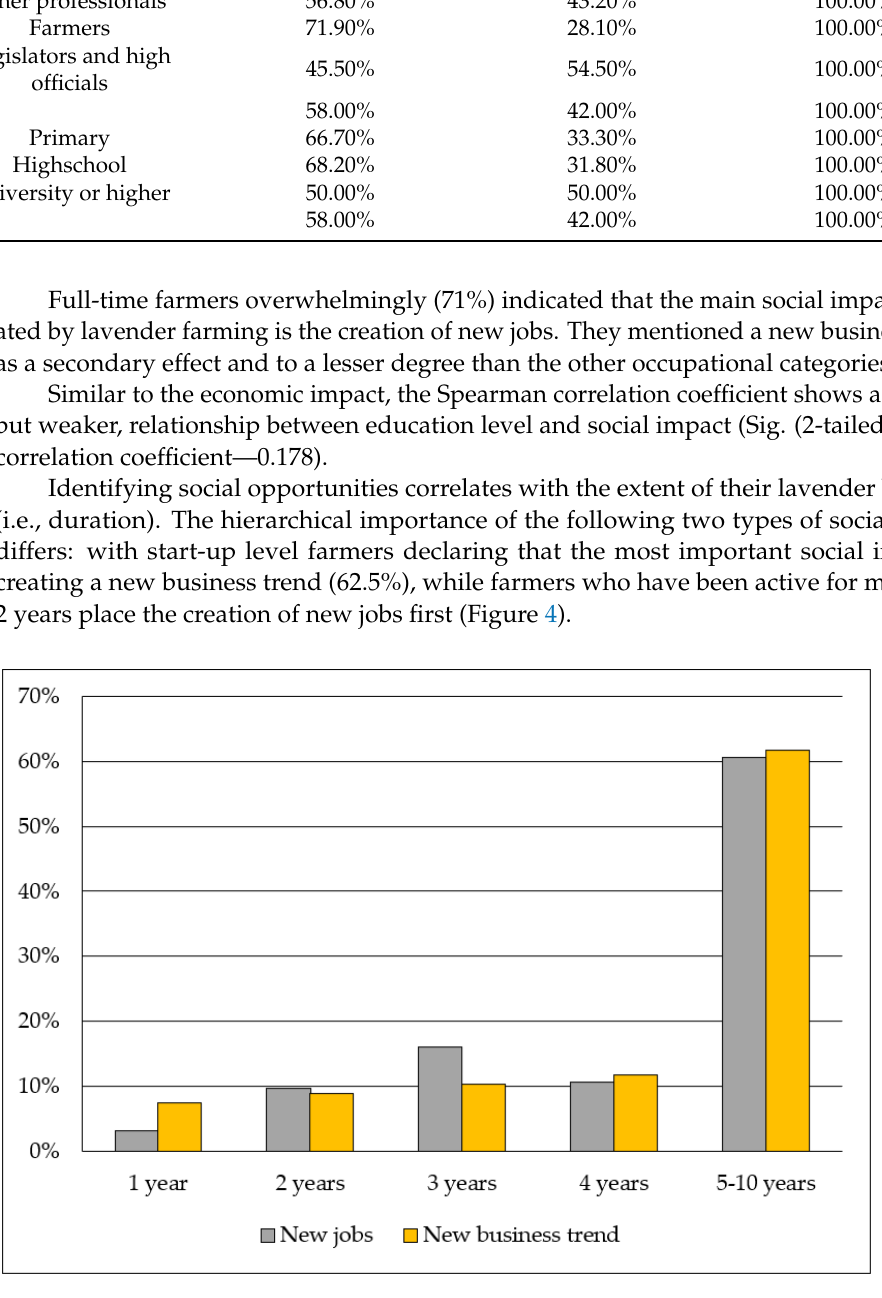
Figure 4. Relationship between the identified social impact of lavender farming and business dura-